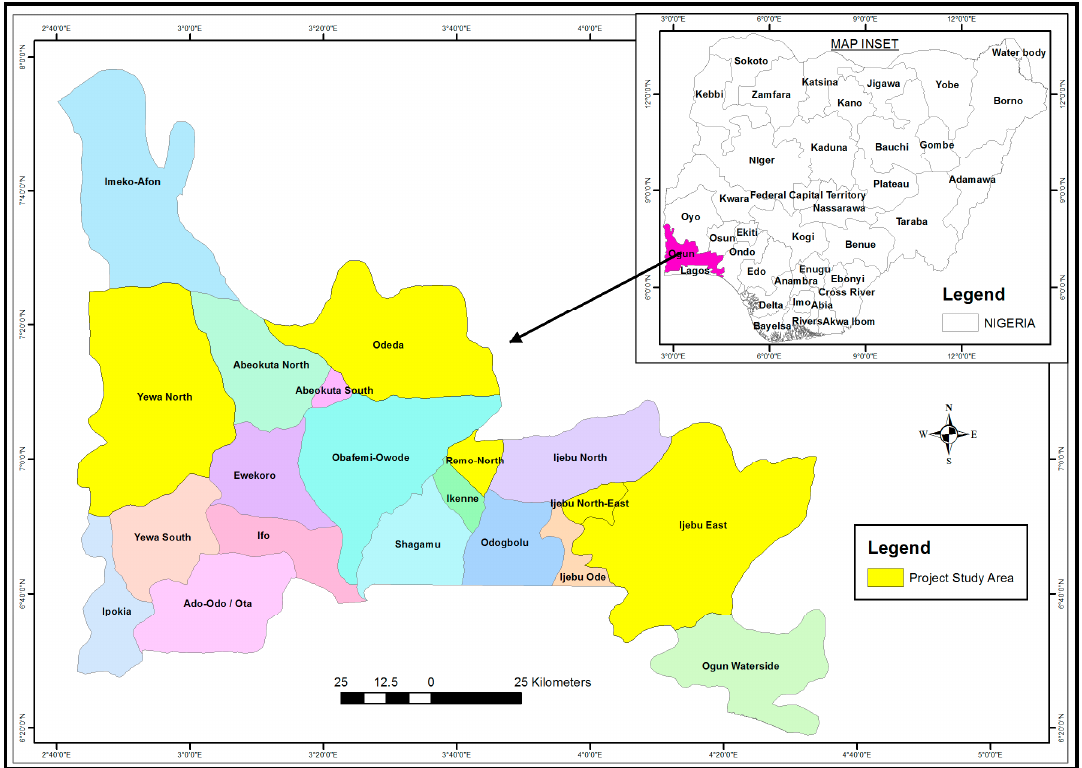
Figure 1. Map of Ogun State showing the study areas in yellow.